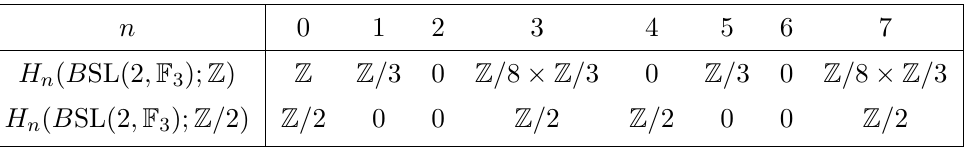
Table 7. The homology groups of B SL(2 , F 3 ) with coefficients in Z and Z / 2 up to degree 7 , as we need to compute the bordism groups up to degree 6 .